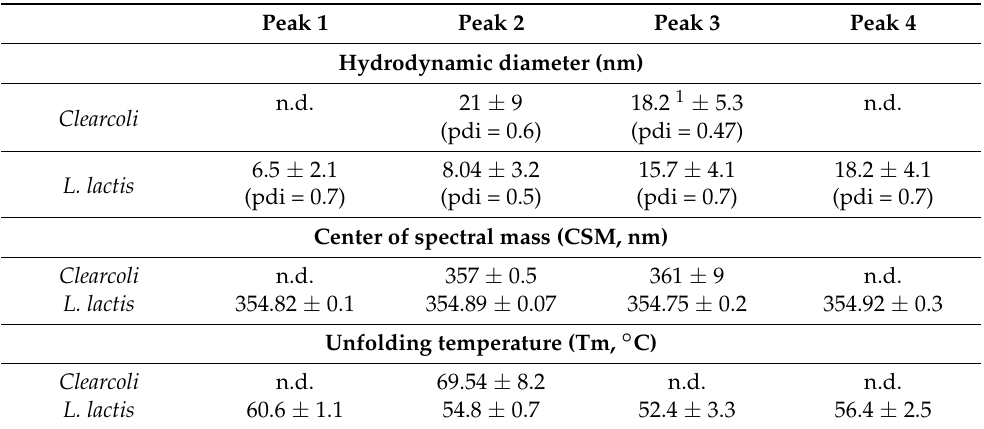
Figure 3. Volume weighted distribution determined by dynamic light scattering (DLS) of MMP-9 peaks from, Clearcoli ( a ) and L. lactis ( b ). Far UV-circular dichroism (CD) spectra of MMP-9 peaks from Clearcoli ( c ) and L. lactis ( d ). Experimental spectra (dotted lines) and fitted spectra (solid lines). (See Materials and Methods Section 3.8). Table 1. DLS, CSM and unfolding temperature of isolated elution protein peaks obtained from L. lactis and Clearcoli IBs after solubilization. Values represent mean and SEM. Not determined (n.d.). Polydispersity index (pdi).